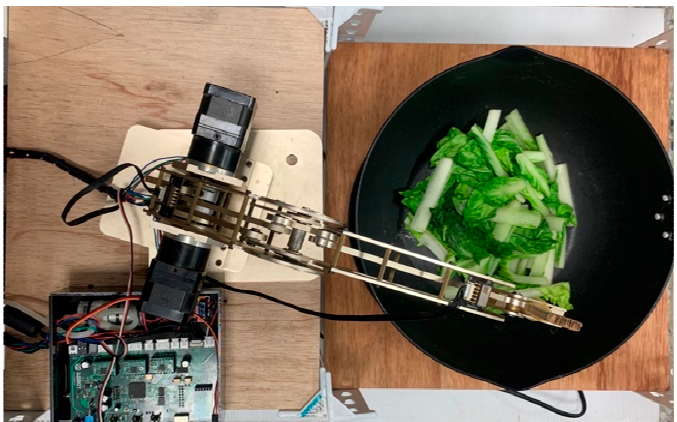
Figure 14. The robotic arm touches the far right end of the pot and stirs. Left: the robotic arm Right: the pot